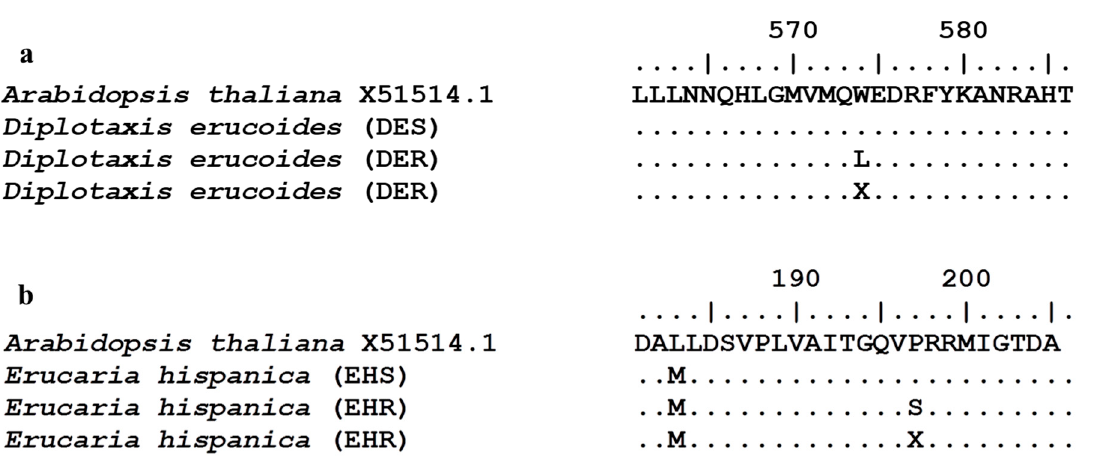
Figure 3. Alignment of partial ALS gene sequence of plants from S and R populations of Diplotaxis erucoides and Erucaria hispanica (DES, DER, EHS, and EHR, respectively). Amoni acid substitutions of Trp574 to Leu in DER plants ( a ) and Pro197 to Ser in EHR plants ( b ). Positions refer to the known ALS gene sequence of A. thaliana ( X51514 ).